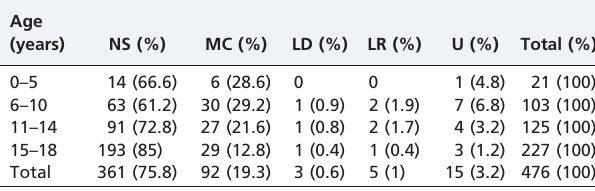
Table 8 - Distribution of pediatric classical